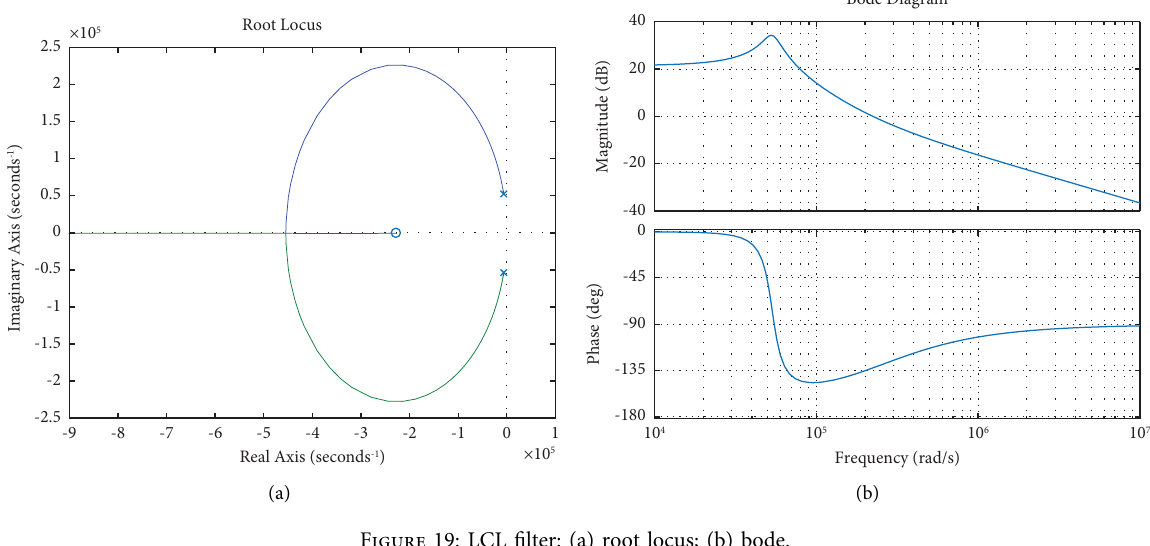
Figure 19: LCL flter: (a) root locus; (b) bode.